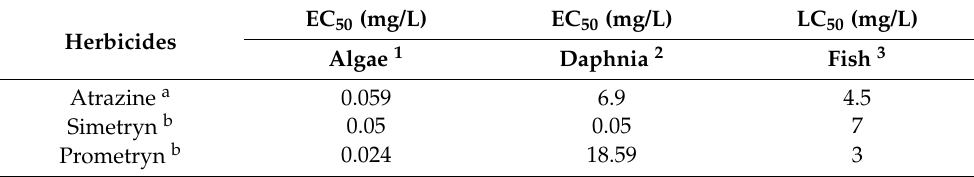
Table 3. EC 50 and LC 50 of the herbicides for three aquatic organisms.